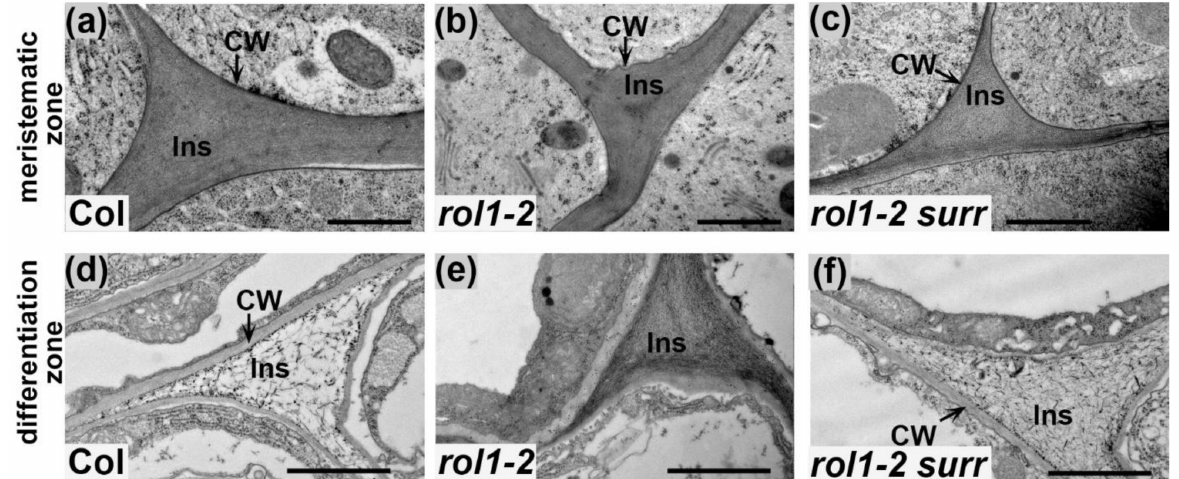
Figure 2. Changes in cell wall architecture in root tissue. Electron microscopic analysis of the cell wall ultrastructure in seedling root tissue. The wild-type cell wall architecture is modified between the meristematic tissue with electron-dense cell walls ( a ) and differentiation zone with much less dense material ( d ). This differentiation is absent in rol1-2 ( b , e ), and re-established by the surr mutation ( c , f ). CW: cell wall; InS: intercellular space, cell corners. Bar = 1 µ